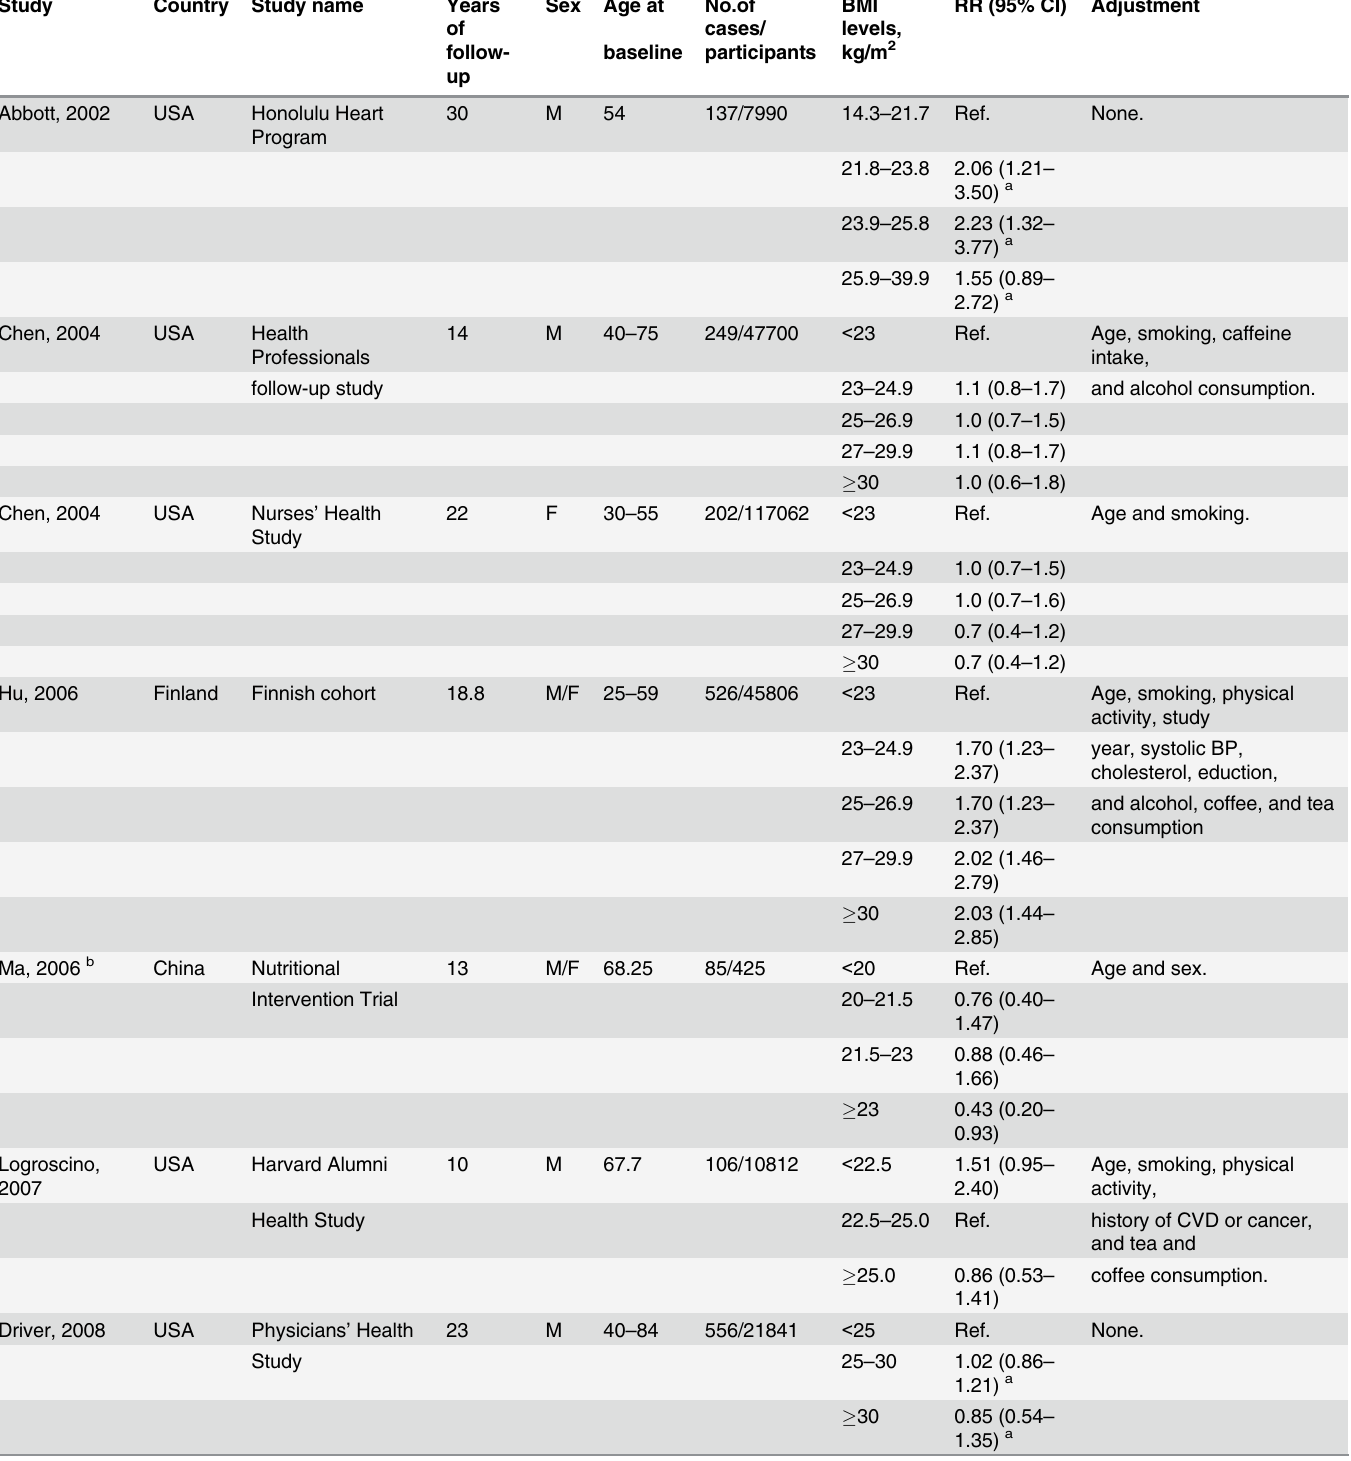
Table 1. Characteristics of included prospective studies on the association between body mass index and risk of Parkinson ’ s